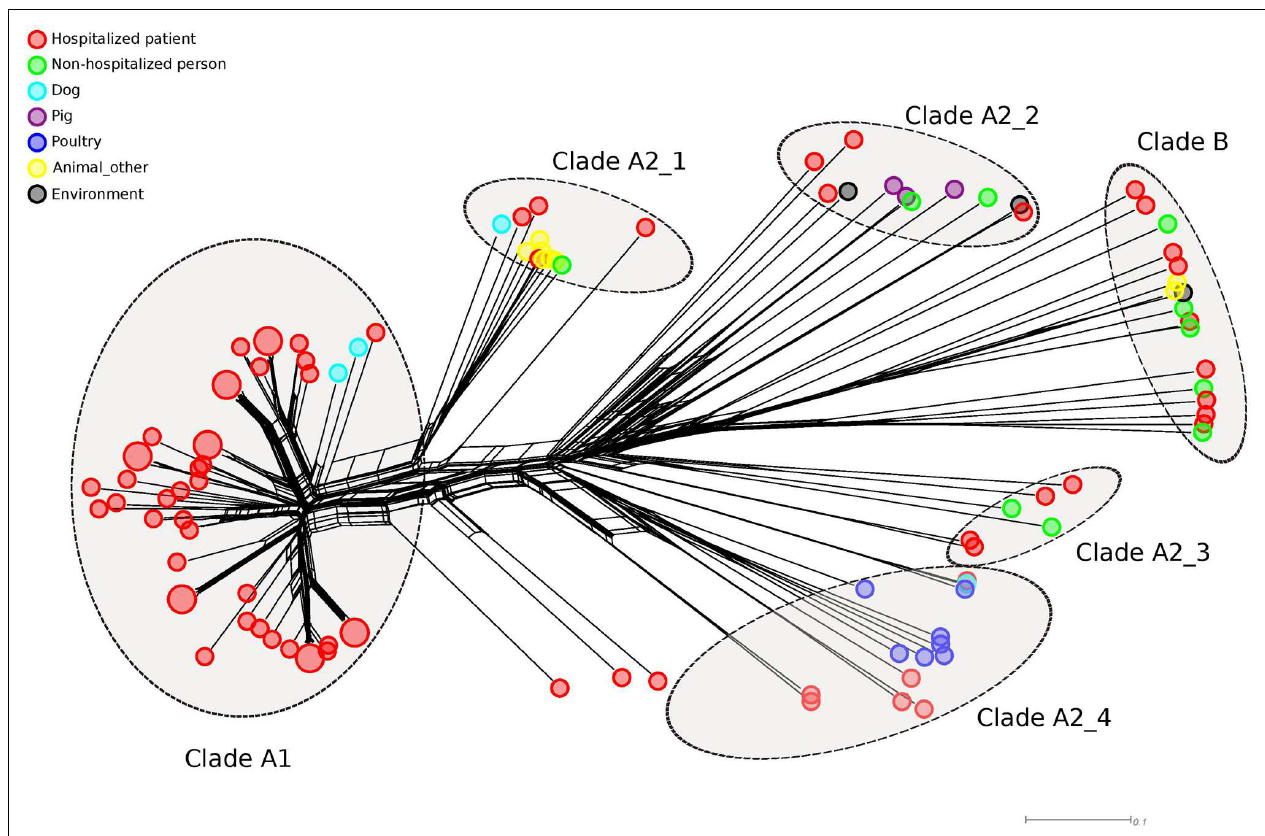
FIGURE 1 | NeighborNet phylogenetic network to visualize the relationships between 196 E. faecium isolates. The distance matrix underlying the network was built from all pairwise allelic profile comparisons of 1423 loci of the published E. faecium cgMLST scheme (de Been et al., 2015). Allelic profiles were extracted from SeqSphere. Small colored circles indicate the origin of isolates. E. faecium clades (A1 and B) inferred from the STs and based on Lebreton et al. (2013) are indicated by large dotted circles. Notably, in this analysis clade A2 isolates do not group in a single clade but form at least four distinct clusters that are located in the network and are indicated clade A2_1, A2_2, A2_3 and